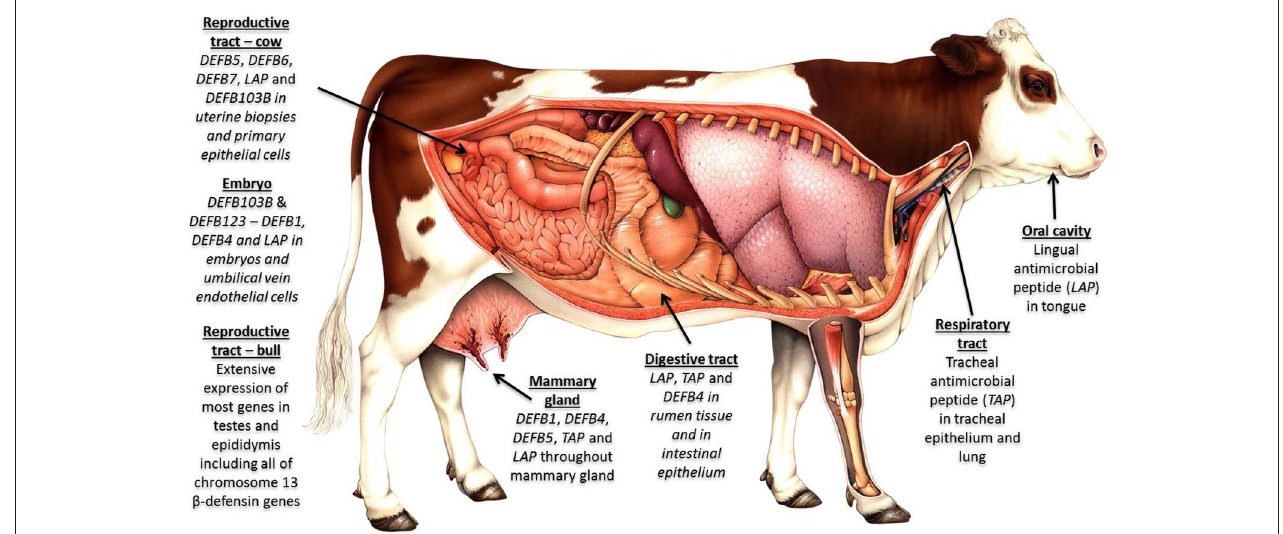
FIGURE 2 | β -defensins as regulators of the microbiome and biosensors of immune homeostasis: Expression of β -defensin genes in bovine tissues—four genomic clusters of these genes exist in cattle on chromosome 8 (4 genes); chromosome 13 (19 genes); chromosome 23 (5 genes); and chromosome 27 (30 genes). The β -defensin genes on chromosome 27 are the least well conserved between species, are known to be CNV and show an expansion in number in cattle. Tissues with immunological privilege (reproductive tract) show particularly extensive β -defensin expression